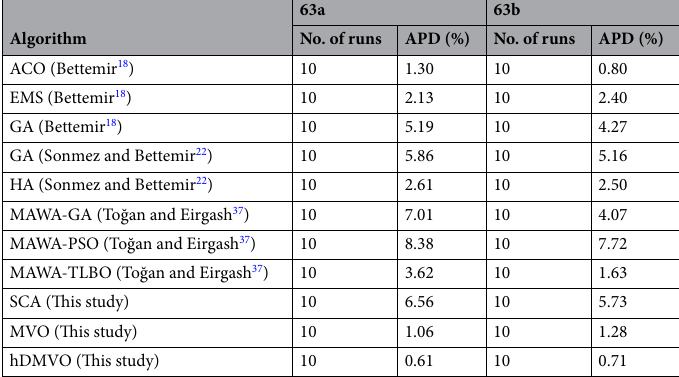
Table 11. Average percent deviation from the optimal for problem 63a and 63b.